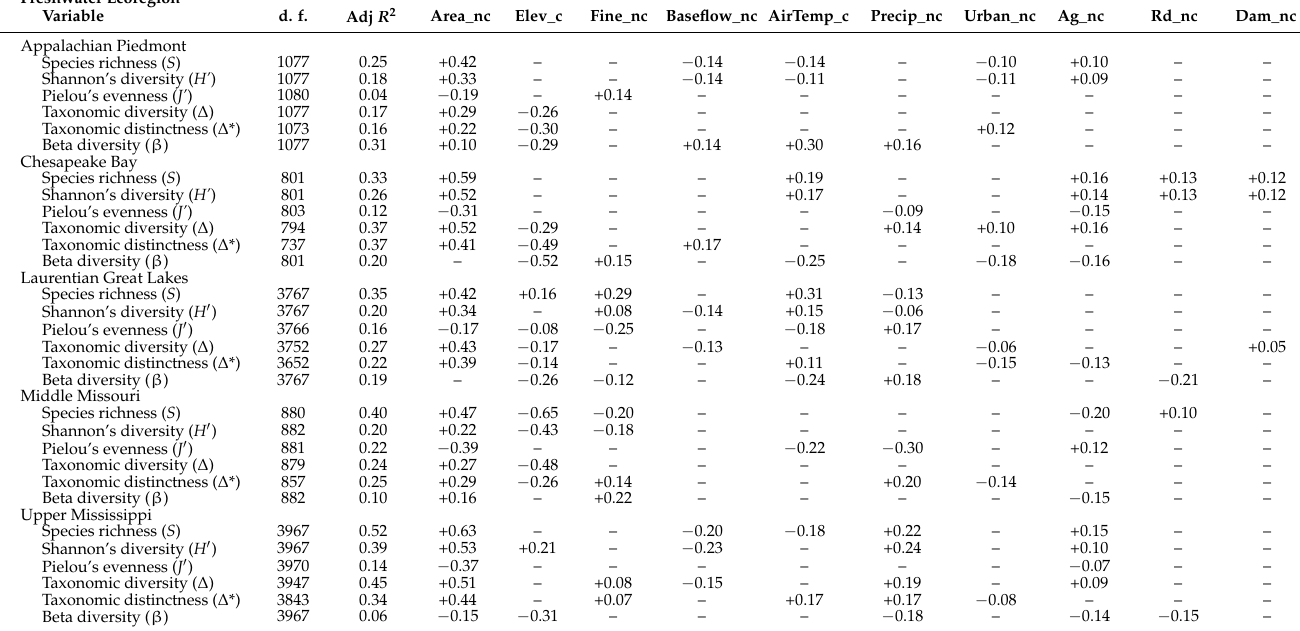
Table 4. Results of multiple linear regression models for the relationships of the biodiversity indices to natural landscape variables and anthropogenic land use variables, with degrees of freedom (d. f.), adjusted R 2 (Adj R 2 ), and standardized regression coefficient ( β ) describing the variable strength in the model and direction of influence on biodiversity indices in relation to variables. Predictor variables are as follows: Area = area; Elev = elevation; Fine = percent fine lithology; Baseflow = percent groundwater contribution to baseflow; AirTemp = mean annual air temperature; Precip = mean annual precipitation; Urban = percent urban land use; Ag = percent agri-cultural land use; Rd = density of stream-road crossings; Dam = density of dams; and c = local catchment summary and nc = network catchment summary. All variables selected for inclusion in best models as predictors for biodiversity indices were significant at p -value ≤